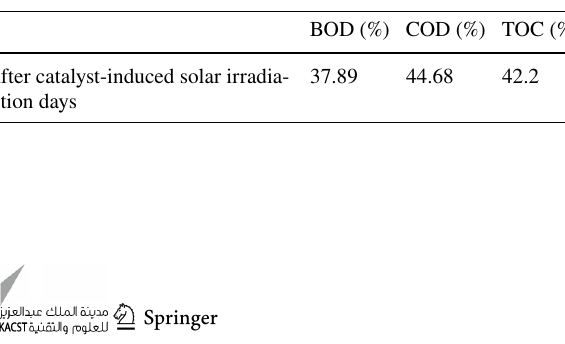
Table 2 Reduction in TOC, COD and BOD of real textile wastewater after the treatment process (40